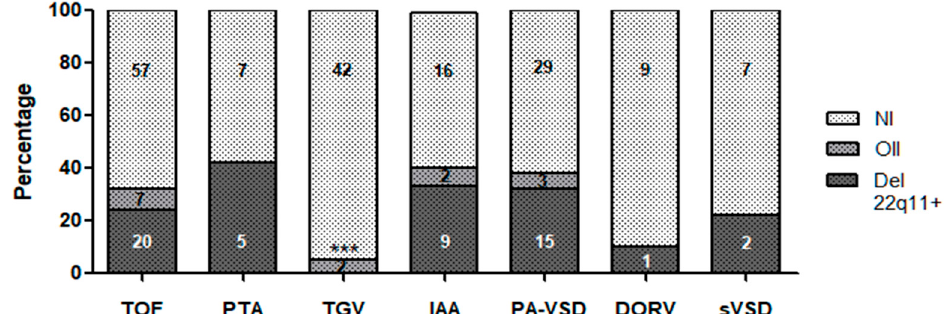
Figure 2. Distribution of 22q11 deletion and other imbalances in the different groups of CCHD studied. Del 22q11 refers to the 3 Mb and 1.5 Mb deletions. CCHD: Conotruncal congenital heart defect; TOF: Tetralogy of Fallot; PTA: Persistent Truncus Arteriosus; TGV: Transposition of the Great Vessels; IAA: Interrupted Aortic Arch; PA + VSD: Pulmonary Atresia with Ventricular Septal Defect; DORV: Double Outlet Right Ventricle; sVSD: Subaortic Ventricular Septal Defect; OII: Other isolated imbalances: refers to imbalances found in patients excluding those observed also with the 22q11 deletion; NI: No imbalances. Inside each chart, the number of patients in each category. Patients who had more than one CHD were included in both categories.